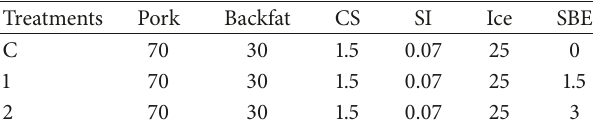
Table 1: Formulation (g) of meat